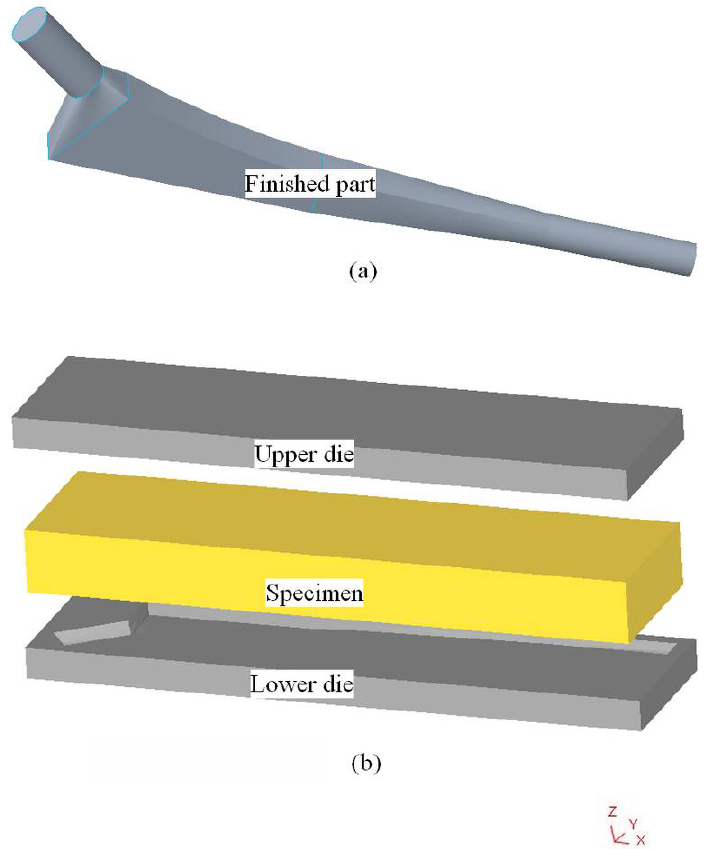
Figure 1. ( a ) Finished hip joint replacement implant for medical application, ( b ) initial billet and upper and lower dies for medical applications. upper and lower dies for medical